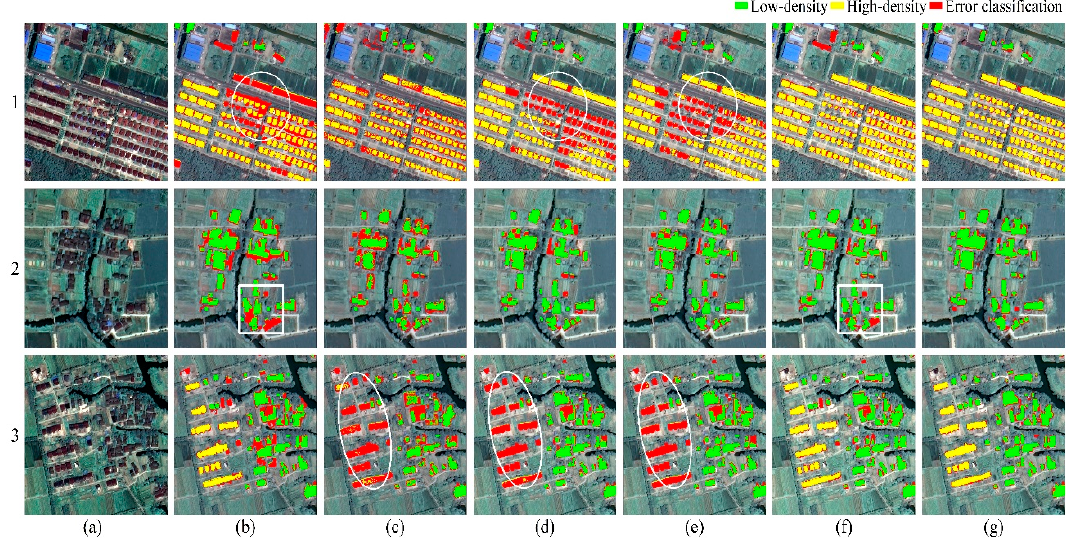
Figure 8. Example of results on Tongxiang polygon test set. ( a ) Original images, ( b ) OBIA, ( c ) FCN, ( d ) UNet, ( e ) SegNet, ( f ) DeeplabV3+, ( g ) The proposed method. Table 5. Accuracy assessment of different methods, where values in bold are the best.